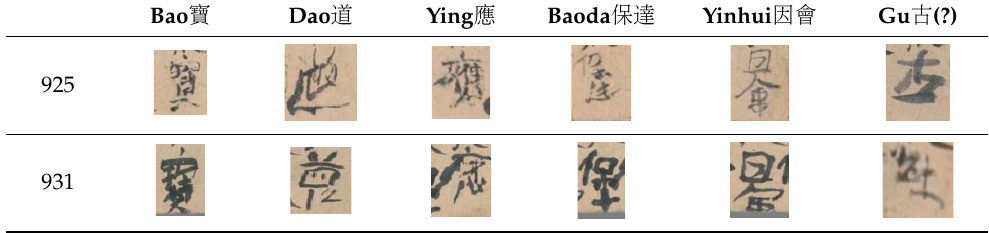
Table 10. A comparative table of calligraphy by Bao and five others in 925 and 931. Bao寶